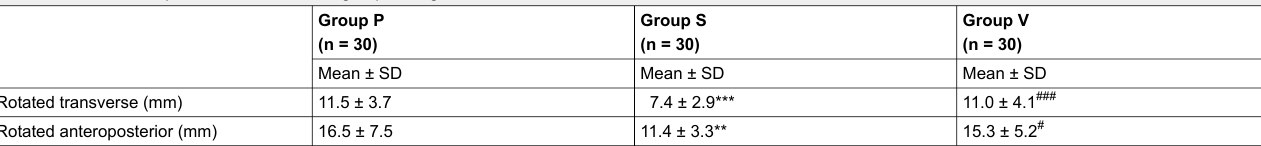
Table 3: Evaluation of parameters in between group